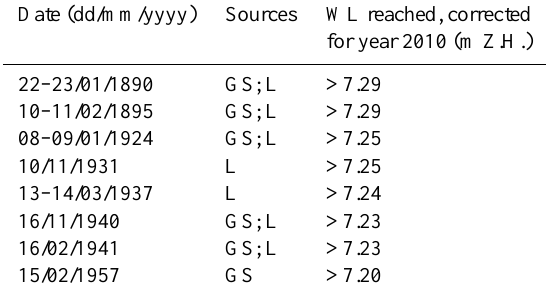
Table 1. Summary of the eight historical flooding events that sub- merged the old harbour dock since 1890. The altitude of the old harbour dock is 7.1m Z.H. Each event reported here has therefore generated a WL higher than 7.1m Z.H. back in the year of the event. Notations for the sources: GS – Garnier and Surville (2010); L – Lambert